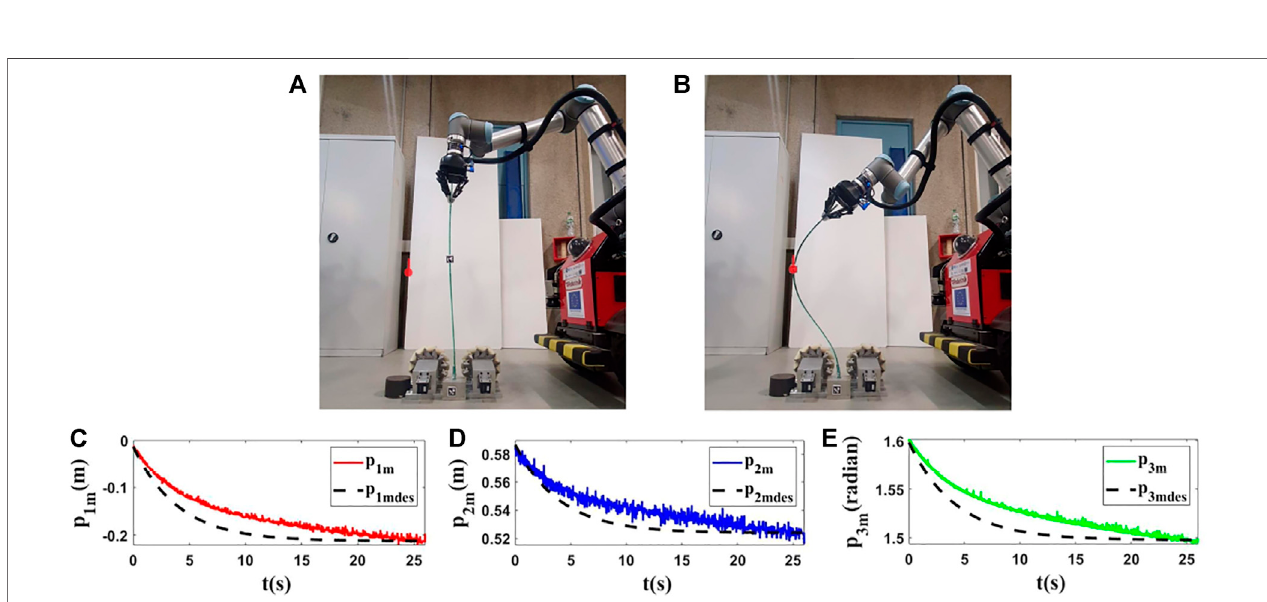
FIGURE11| Experiment2.Firstrow: (A) and (B) aretheinitialand fi nalshapeoftheobject,respectively.Thedesiredstateof m isshownasaredcirclewithasmall line segment. For this test, we assume that M 0 is [0.010,0.232,1.507] T and we want to move it to M fdes = [ − 0.036,0.217,1.030] T . The fi nal state of the controlled point is M f = [ − 0.039,0.216,1.043] T . Second row: (C – E) are the evolution of the states in the second experiment with respect to their desired trajectories.